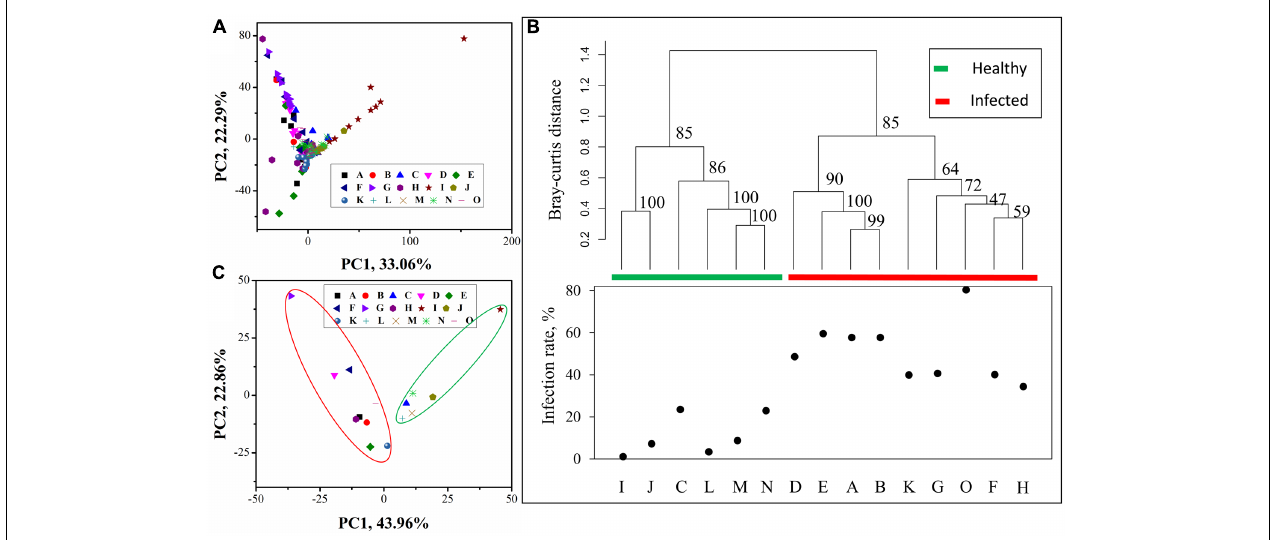
FIGURE 2 | Principle component analysis (PCA) and Unweighted paired group method with arithmetic mean (UPGMA) tree of microbial community composition. (A) PCA plot of all 147 samples grouped by sample sites; (B) UPGMA tree constructed from ‘Bray–Curtis’ distances between microbial community in each site, sites were clustered into two groups based on the community composition and as the two groups differed in the wilt infection rate, they were referred to ‘healthy’ (which had the infection rate lower than 25%) and ‘infected’ group (which had the infection rate higher than 25%), respectively. The numbers associated with the branches refer to bootstrap values (confidence limits) resulting from 100 replicate resamplings; (C) PCA plot of microbial community in sample sites. In (B,C) , average relative abundance in each site was used for analysis.